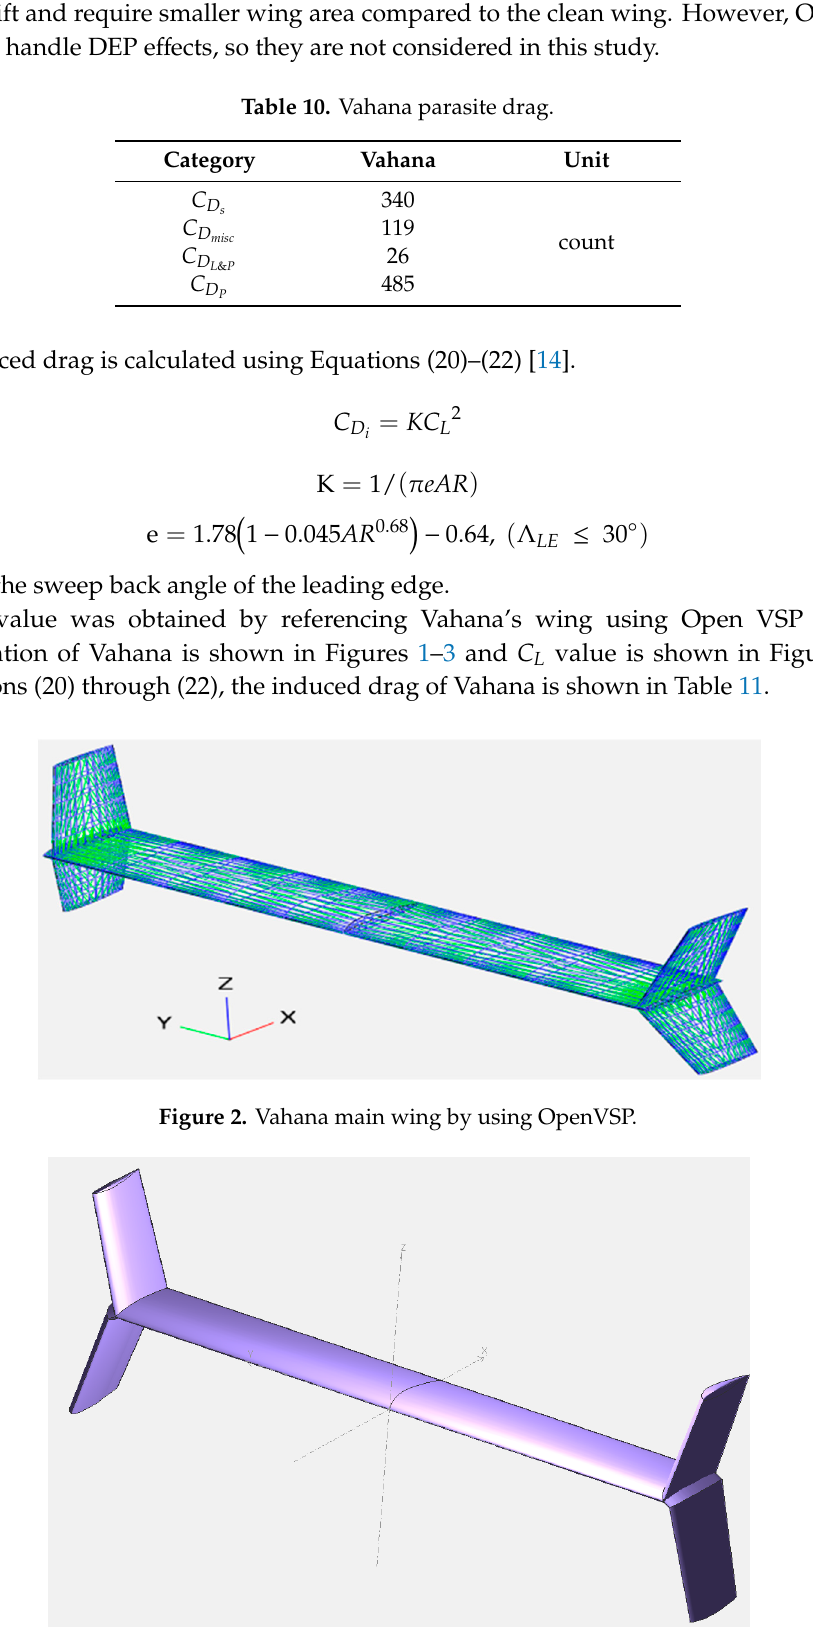
Figure 4. Vahana CL calculated using OpenVSP. Figure 5. Vahana C L calculated using XFLR5.